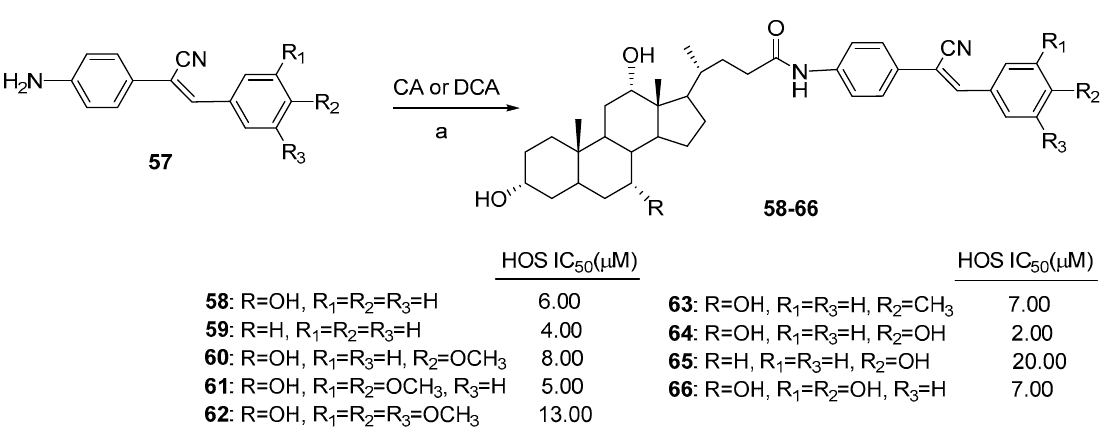
Scheme 9. Synthesis of α -cyanostilbene hybrids. Reaction condictions: (a) EDC, HCl/HOBt/Et 3 N, DMF, MW, 80 °C, 1 h